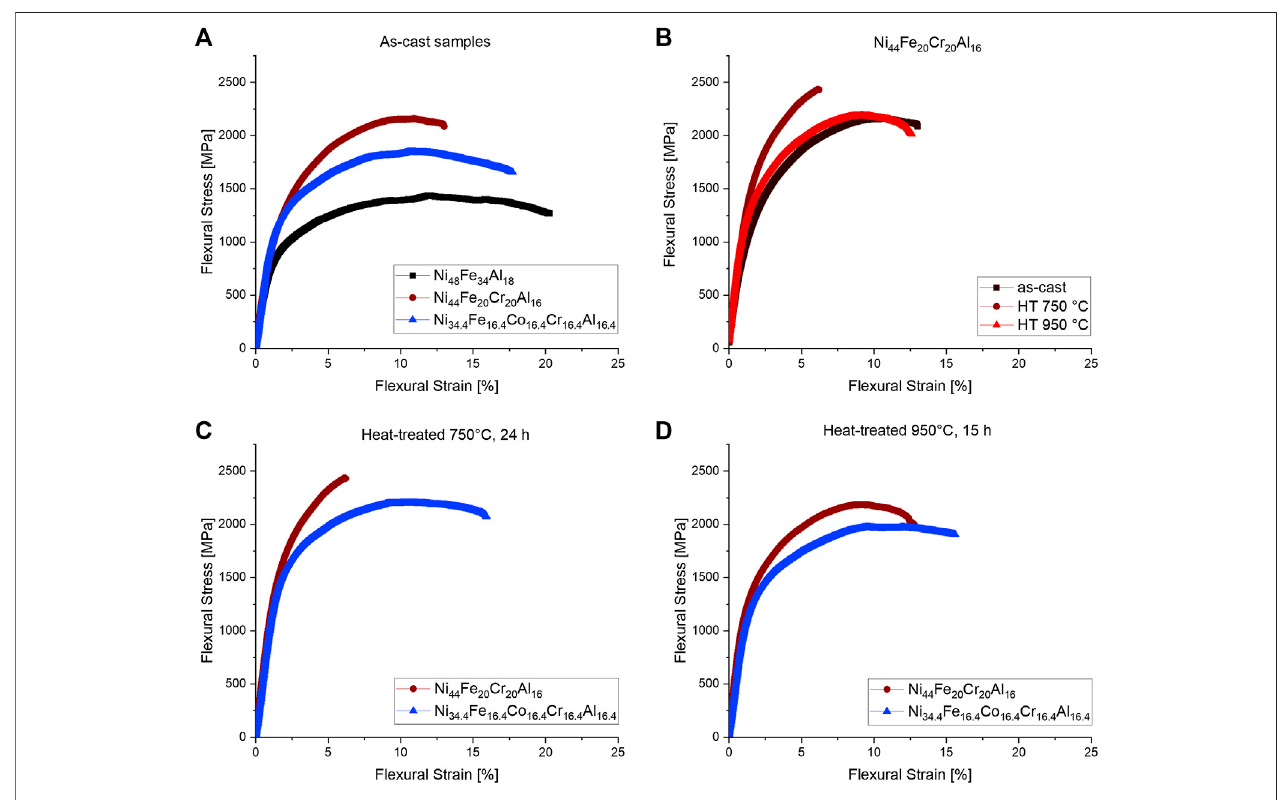
FIGURE 8 | Comparison of results from three point bending experiments of as-cast alloys (A) , the Ni 44 Fe 20 Cr 20 Al 16 alloy after different treatments (B) , both the Ni 44 Fe 20 Cr 20 Al 16 and Ni 34.4 Fe 16.4 Co 16.4 Cr 16.4 Al 16.4 alloys after heat treatment at 750 ° C for 24 h (C) , and after heat treatment at 950 ° C for 15 h (D) .